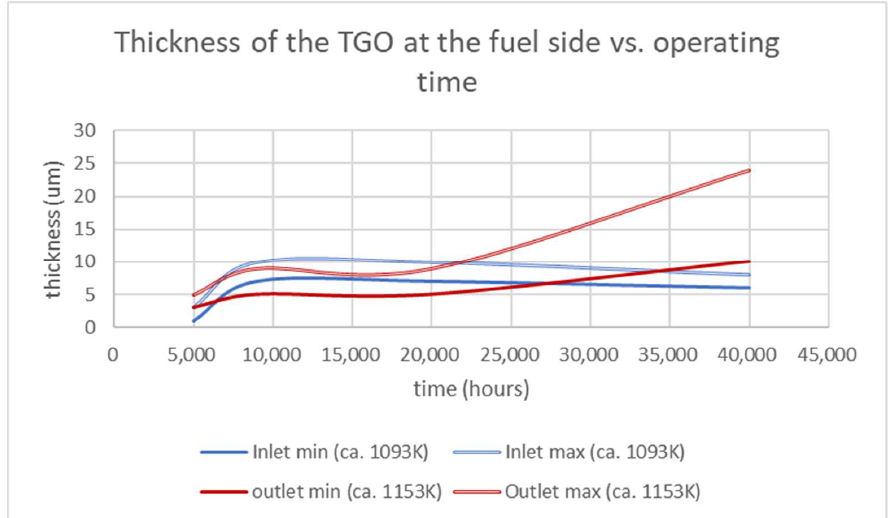
Figure 11. Graphical representation of the lower and higher thicknesses at the fuel side of the TGOs measured on interconnects extracted from similar stacks operated for differing periods (i.e., 5000; 9000; 20,000; 40,000 h).